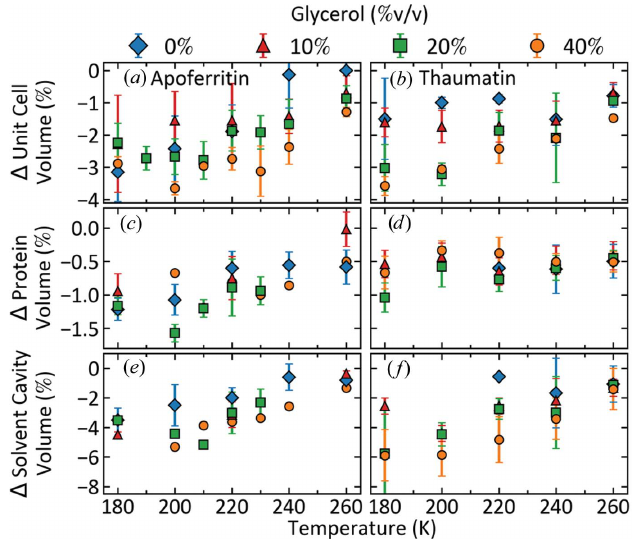
Figure 5 Changes in the unit-cell, solvent-cavity and protein volumes from their room-temperature values versus temperature for apoferritin (left column) and thaumatin (right